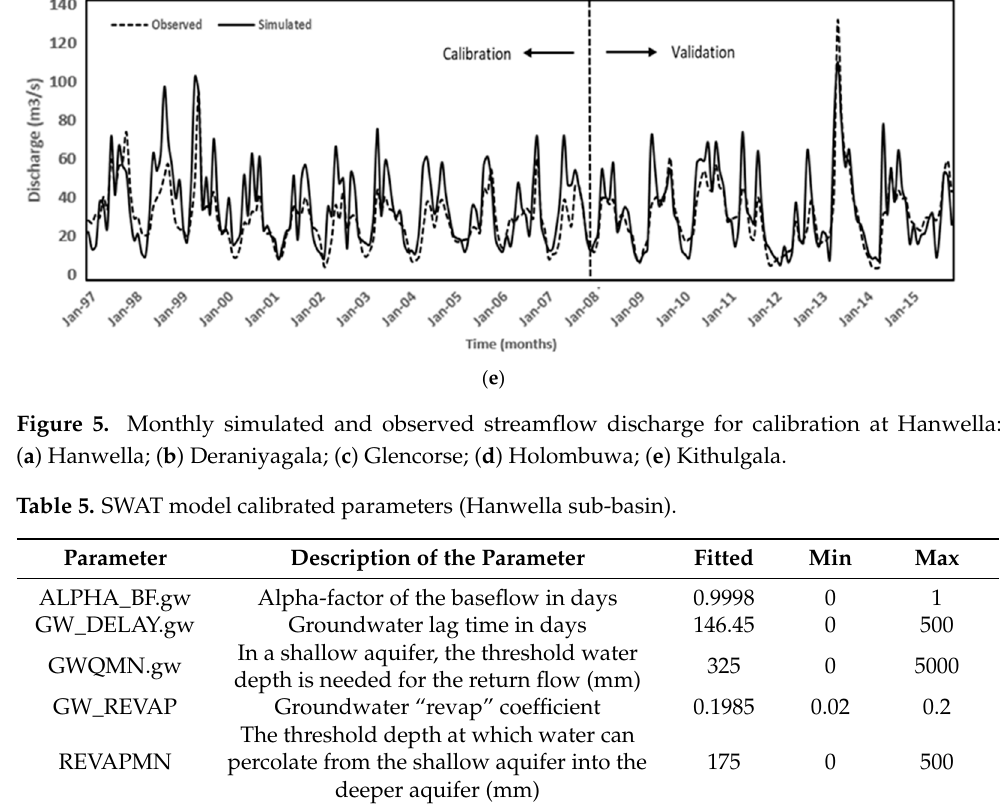
* CN2.mgt values were varied with the land use (forest: 80, settlements: 90, agriculture: 80, water bodies: 92, bare Table 4. Performance evaluations for the monthly discharge simulation (Hanwella sub-basin). lands: